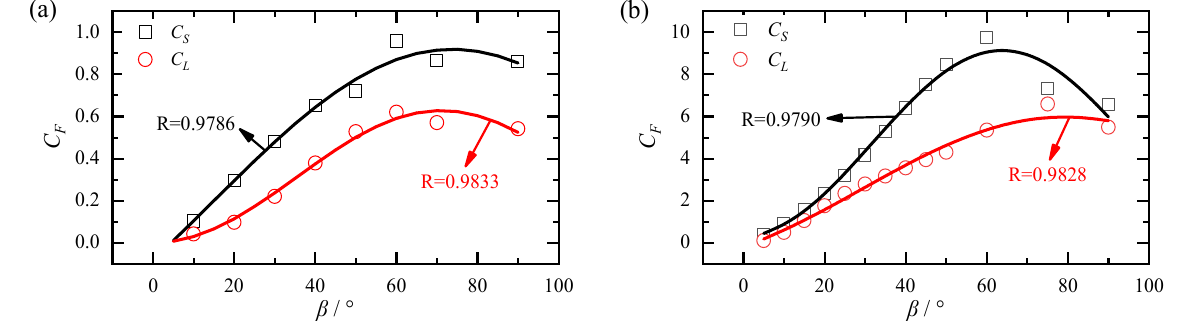
Figure 13. Prediction results of aerodynamic coefficients for different types of trains: ( a ) Advanced Passenger Train; ( b ) ICE 3 leading vehicle.